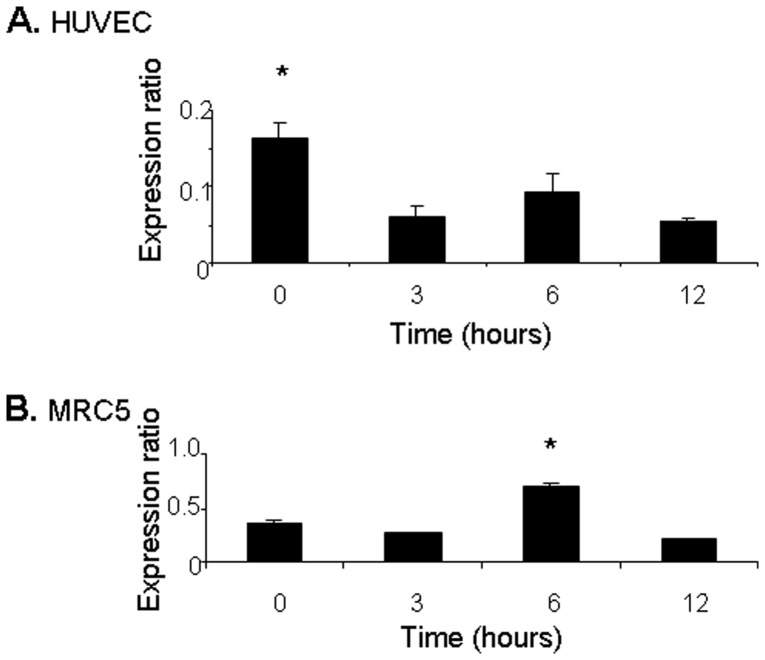
SDF-1α expressed by fibroblasts but not HUVEC cells following LPS treatment.
A)SDF-1α mRNA expression was assessed after endotoxic injury in HUVECs with an early decrease in expression that was evident at 3 hours and persisted up to 12 hours. (* p>0.05). B) Following LPS treatment of MRC5 cells, mRNA expression of SDF-1a is increased after 6h (* p<0.05). Gene expression is reported relative to GAPDH.